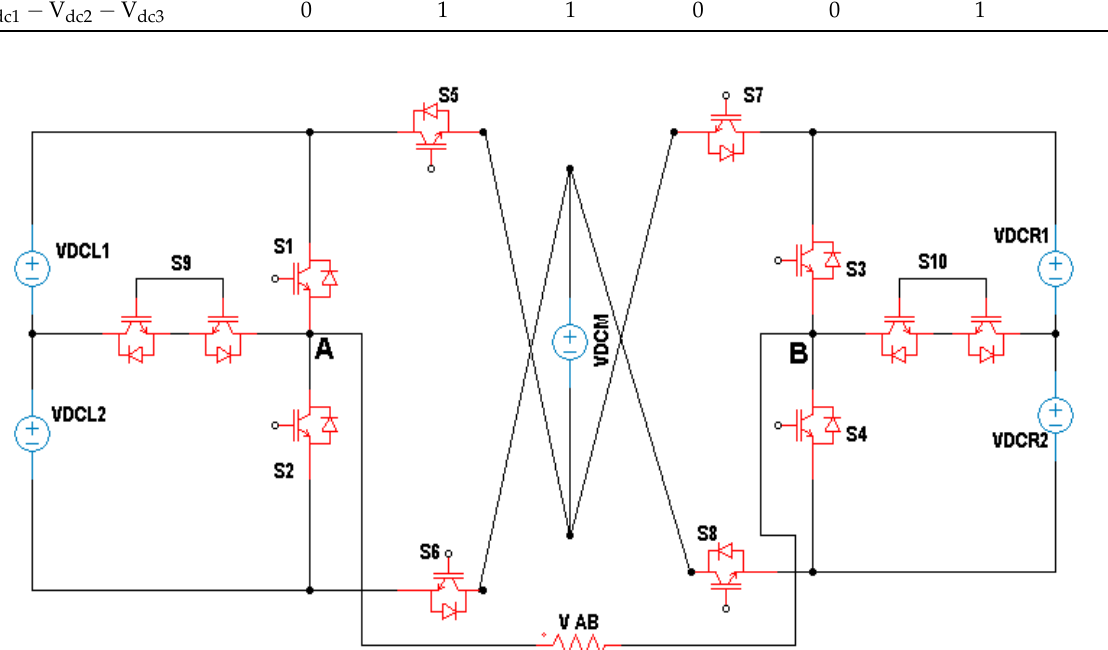
Figure 13. ST-Type module of multilevel inverter.